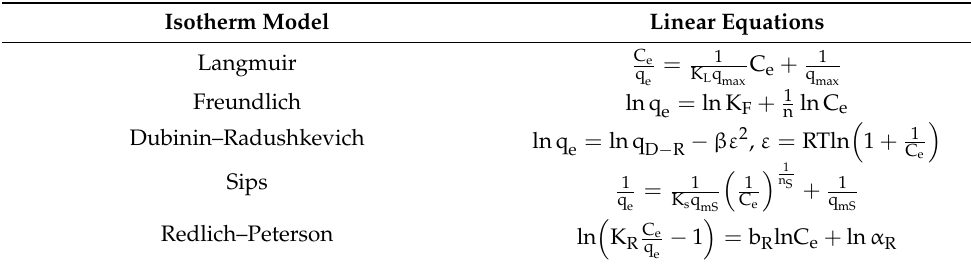
Table 3. Linear equations of isotherm